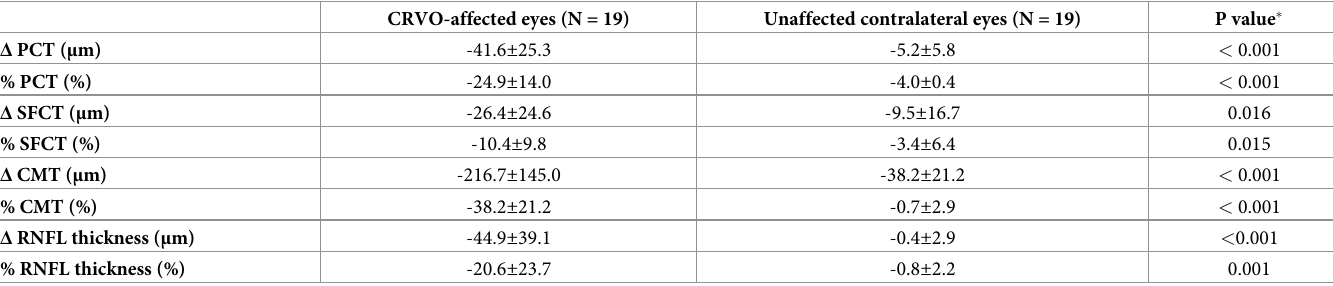
Table 2. Comparison of changes between central retinal vein occlusion affected eyes and unaffected contralateral